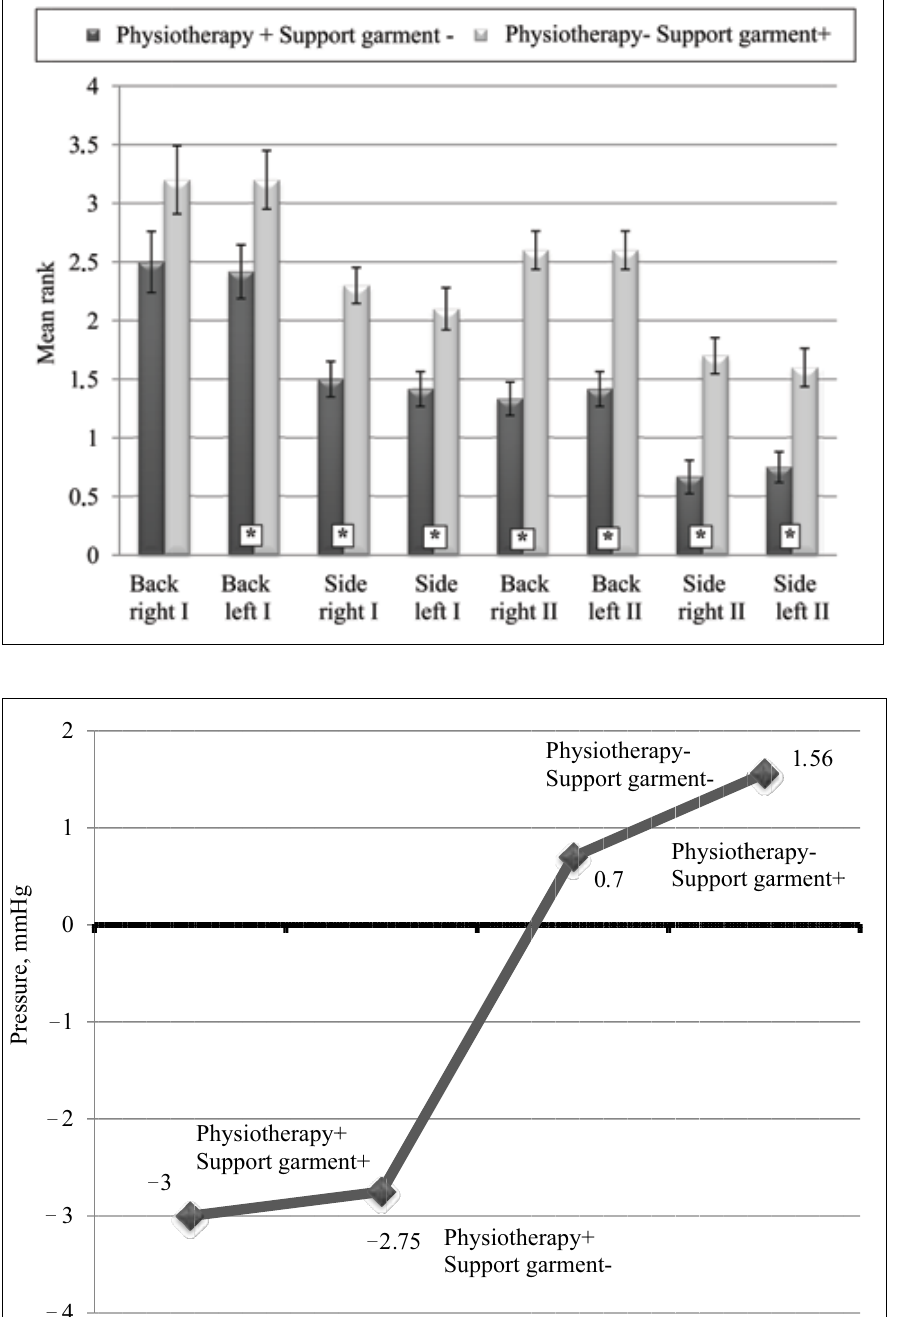
Figure 2. Spinal stability differences depending on presence (+) or absence (–) of physiotherapy and maternity support garment